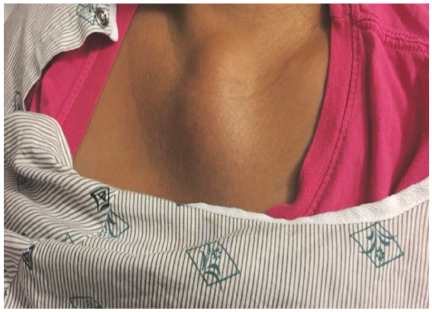
Figure 1: Anterior central chest wall mass.